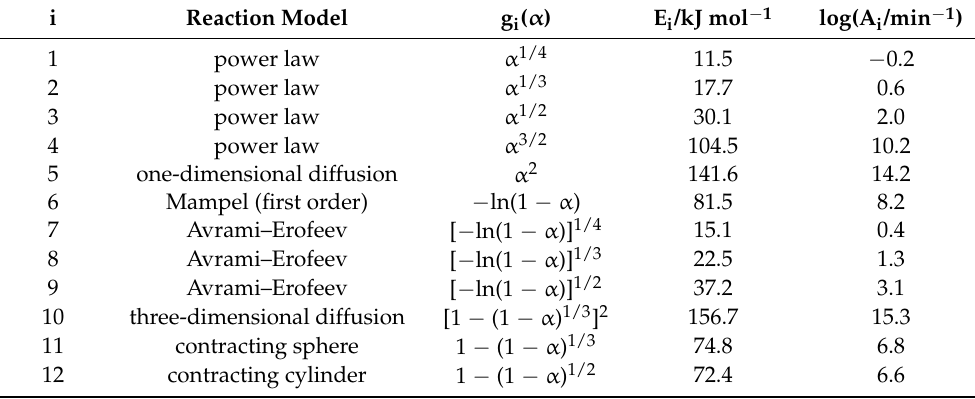
Table 1. Activation energies for the thermal decomposition of ammonium nitrate determined using 12 different models. Adapted with permission from Vyazovkin et al. [13]. Copyright 2001